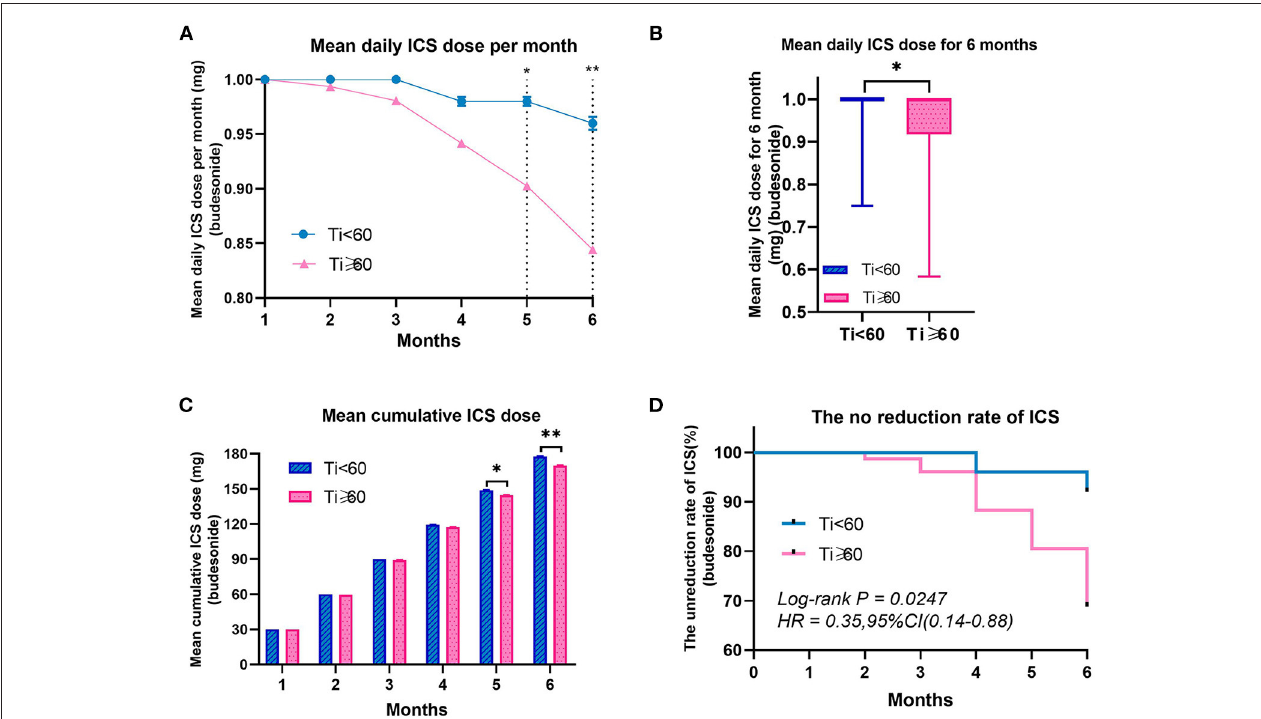
FIGURE 6 | Use of Inhaled Corticosteroids Related Characteristics of Pre-schoolers with Asthma by Groups. (A, C) Data were calculated using a generalized estimating equation model adjusted for month. The data are presented as mean ± SEM. ICSs indicate inhaled corticosteroids. Ti, TRACK initial score. ** P < 0.01; * P <